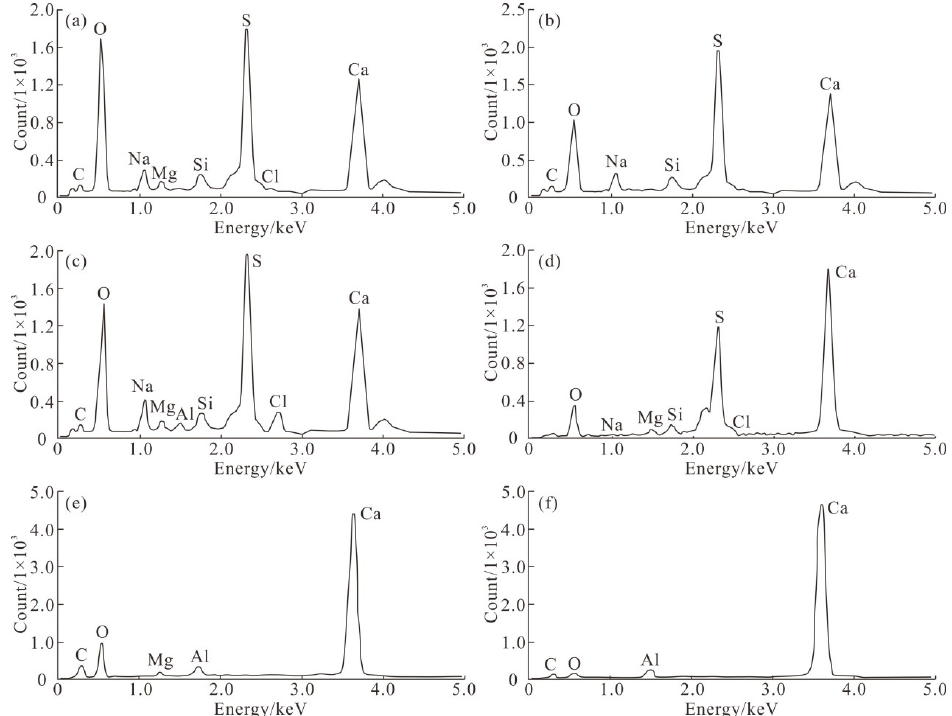
Figure 4. EDX results for precipitated salt samples from the multi-stage fans. ( a , b ), Megadune to the east of Zhalate Lake. ( c , d ), Central part of the windward slope of the megadune to the east of Huhejilin Lake. ( e , f ). Multi-stage fans to the east of Zhalate Lake and to the west of Yinderitu Lake.